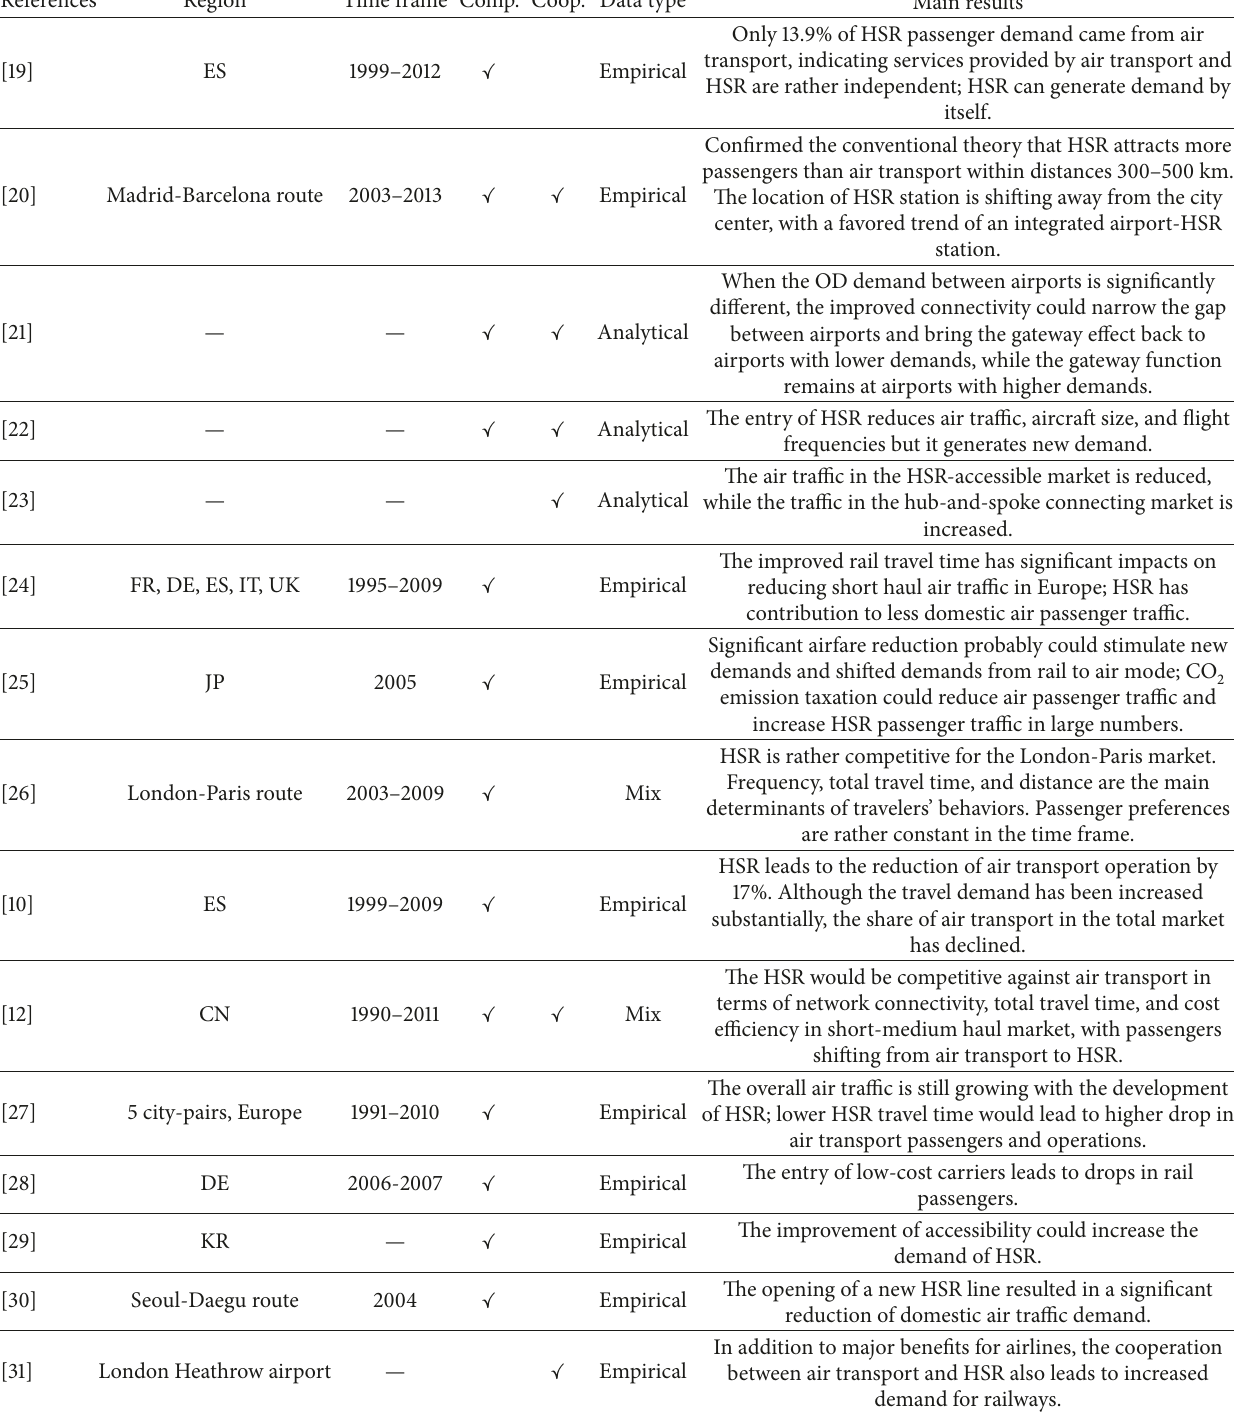
Table 5: The competition and cooperation effects between air transport and HSR on passenger